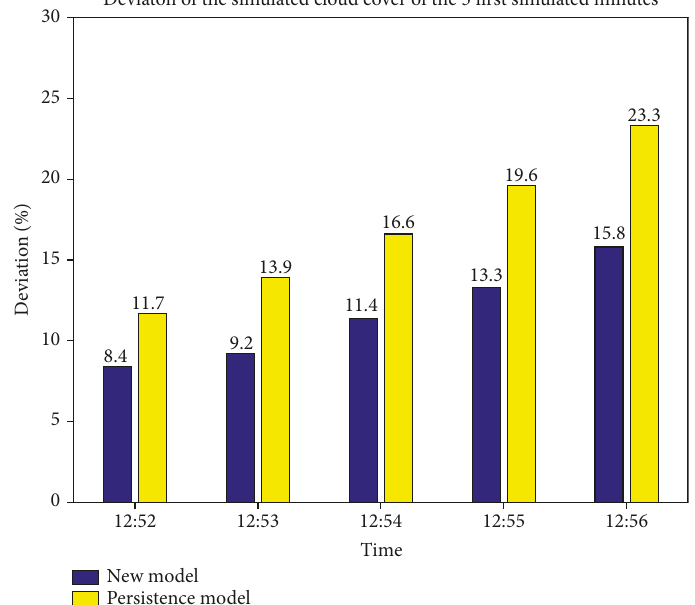
Figure 6: Deviation between the simulated cloud cover of the new model and the persistence model on 22nd June 2014 from 12:52 until 12:56.